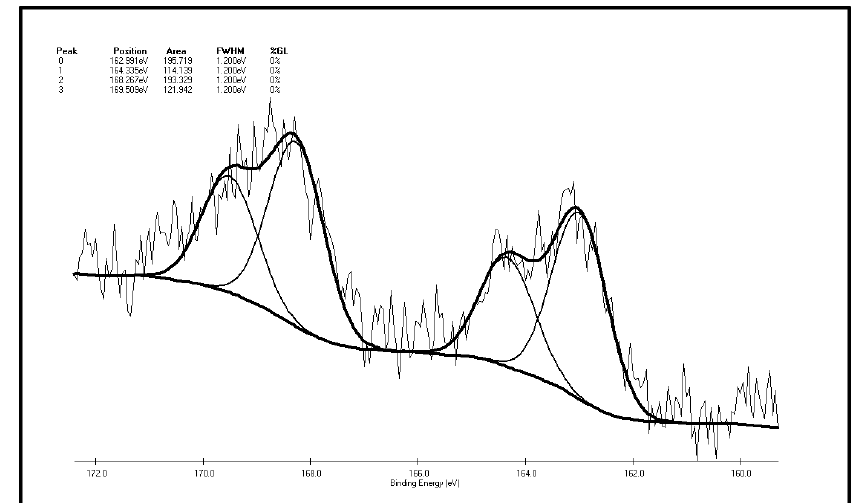
Figure 7. S 2p spectrum of the XF original coal sample.